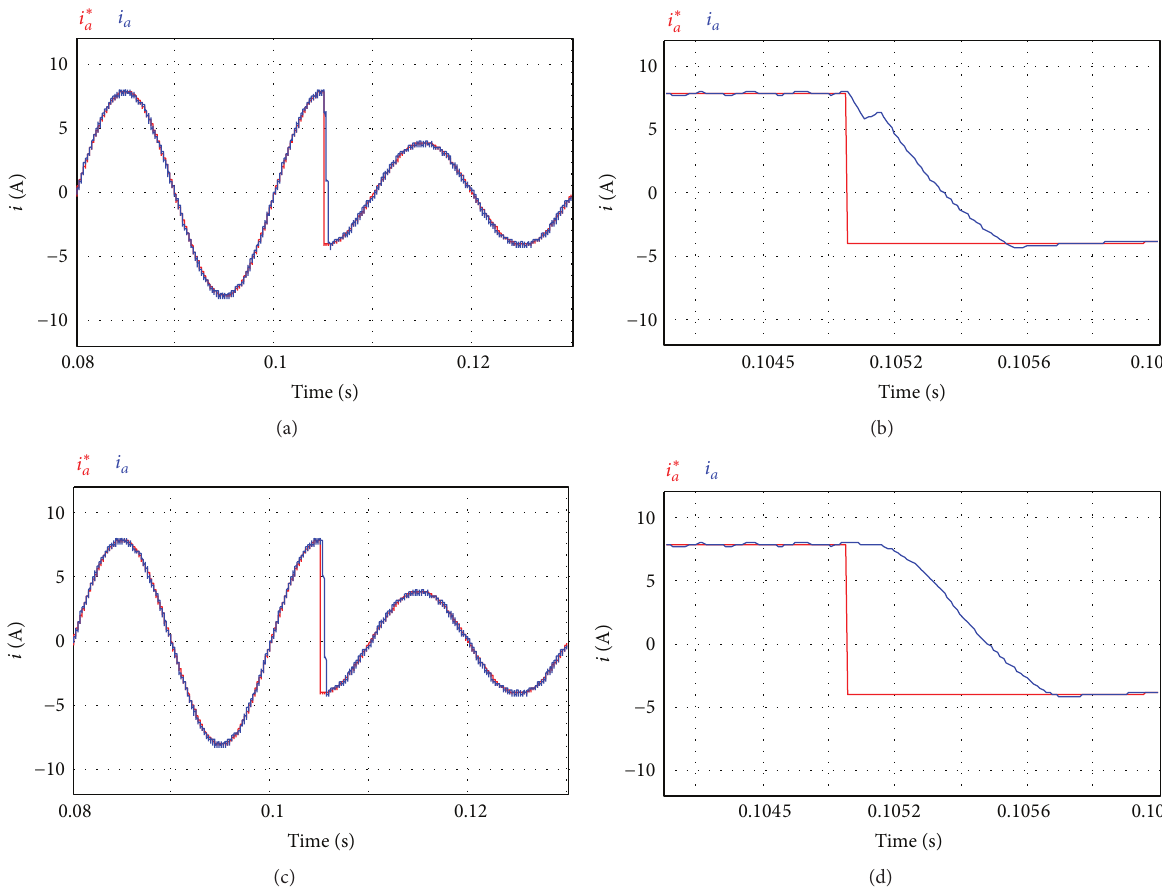
Figure 6: Grid-connected current for a step change in the reference amplitude. (a) Grid-connected current with conventional FS-MPC. (b) Detail of the reference step change showing the grid-connected current with conventional FS-MPC. (c) Grid-connected current with simplified FS-MPC. (d) Detail of the reference step change showing the grid-connected current with simplified